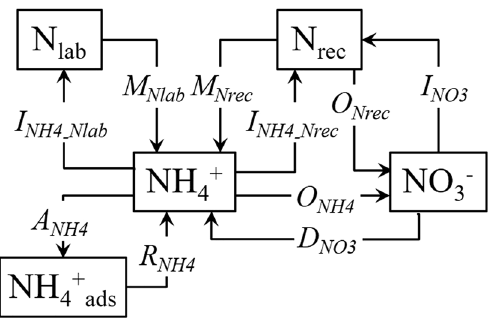
Figure 1. 15 N tracing model used for data analysis. ( N lab labile soil organic N, N rec recalcitrant soil organic N, NH 4+ ads adsorbed NH 4+